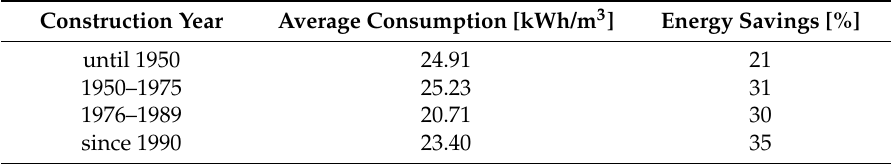
Table 1. Average consumptions and the energy savings of the buildings’ stock.